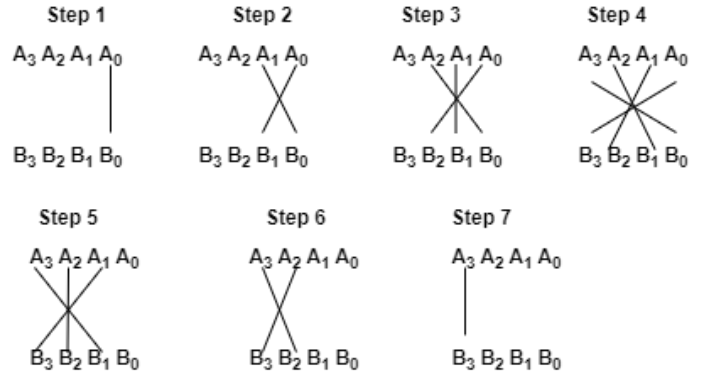
Figure 17. High level overview of quantum multiplication circuit for a SPFP number. Intermediate outputs that are generated must be set back to the original state by running the compute block backward.